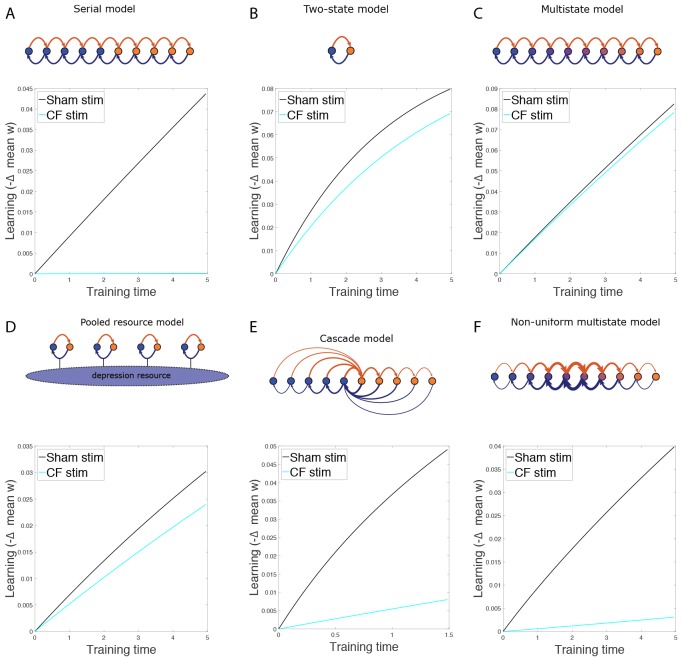
The effect of non-specific CF stimulation.(A−F) Simulation results for various models, showing decrease in mean synaptic weight over time during gain increase training from the normal state (black) and after non-specific CF stimulation (cyan) for wild-type models.